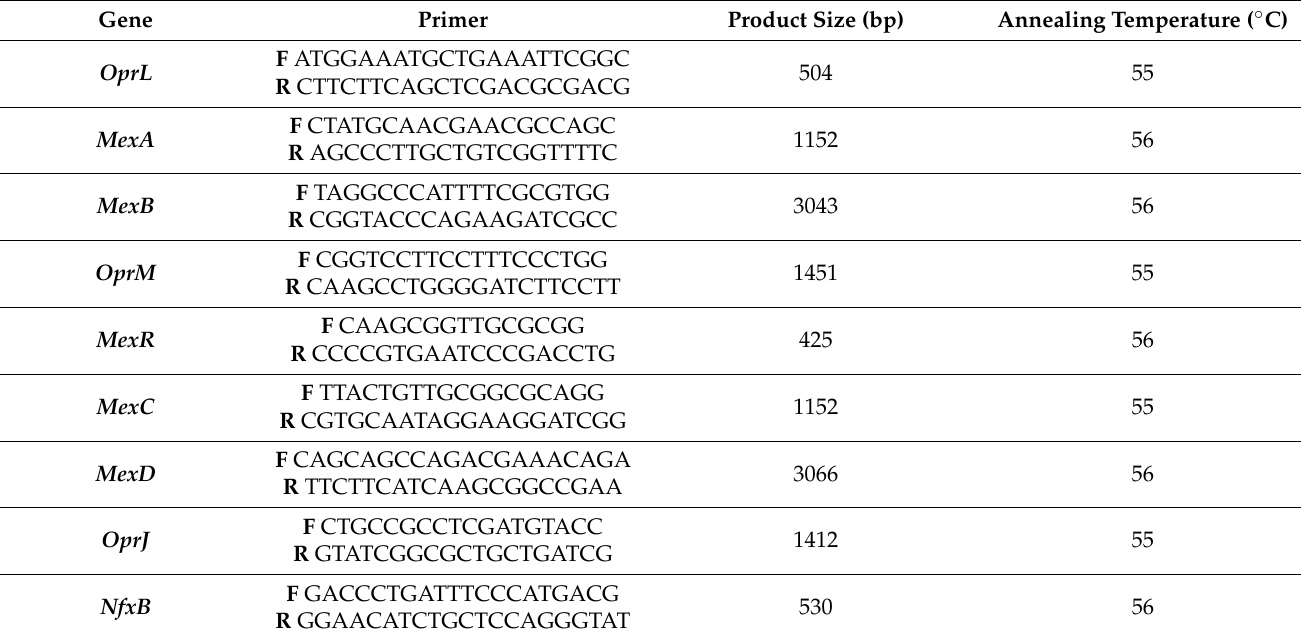
Table 1. Primer sequences with optimized PCR conditions.